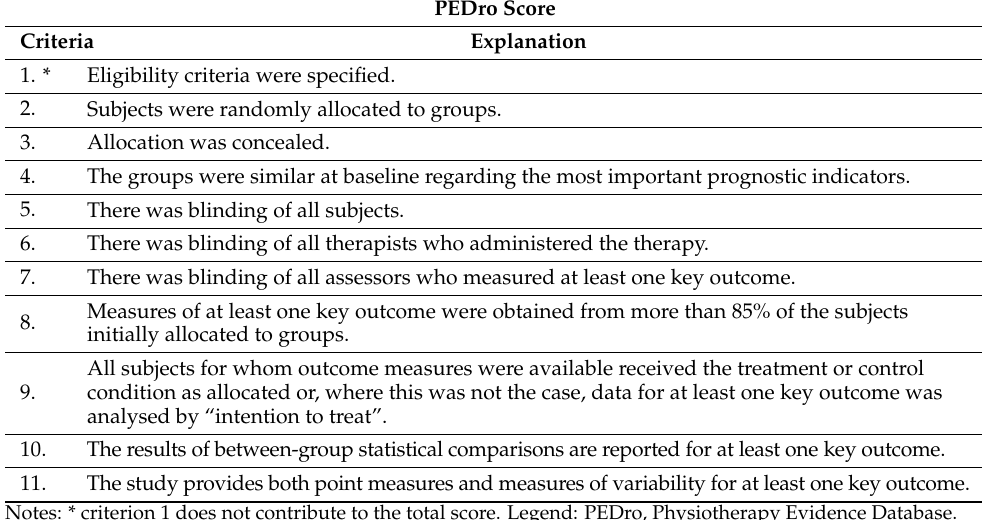
Table A1. Methodological quality of studies according to PEDro score [33].